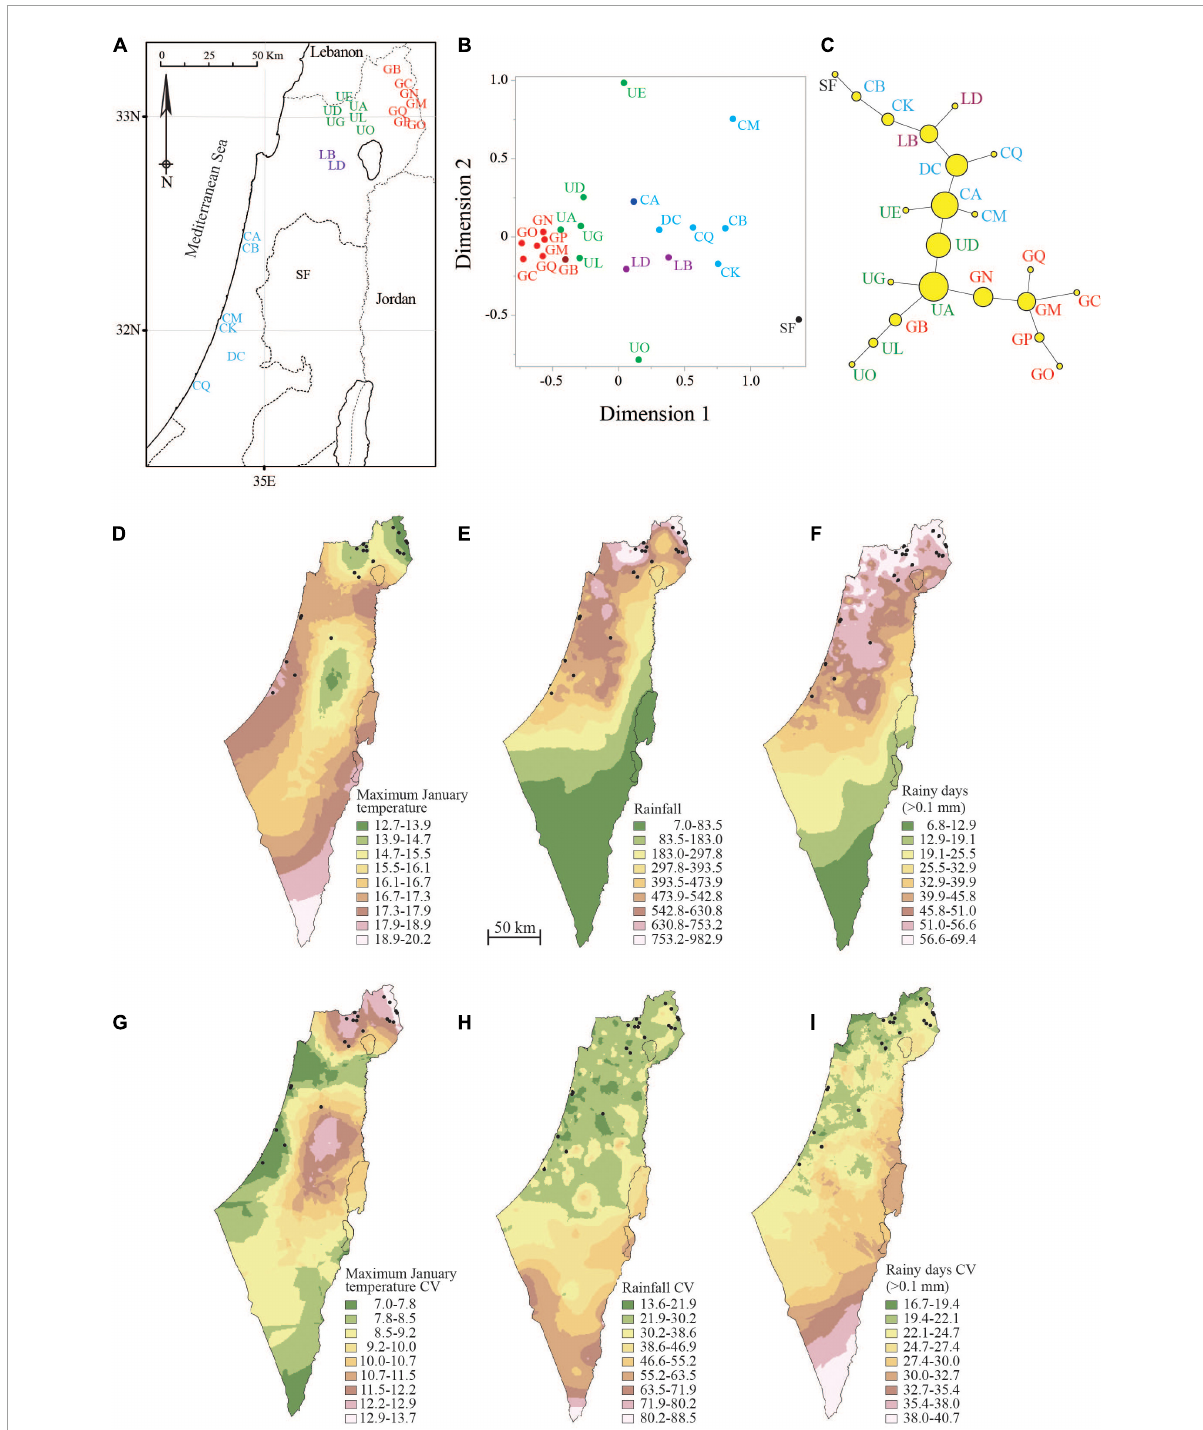
FIGURE1 Location of sampled pools (A) , PROXSCAL multidimensional scaling (B) and minimum spanning network of Nei’s D A distance (C) between pools, spatial projection over Israel of mean annual maximum temperature in January ( D ; ◦ C), mean annual rainfall ( E ; mm), mean annual number of rainy days ( F ; > 0.1 mm), coefficient of variation (CV) of annual maximum temperature in January ( G ; %), CV of mean annual rainfall ( H ; %), and CV of mean annual number of rainy days ( I ; %). Climatic data (133 temperature recording stations and 559 rainfall monitoring stations across Israel) were obtained from the Israel Meteorological Service (IMS) for the years 1999–2018. Vernal pools sampled in this study are denoted by region-colored codes or circles (Golan Heights—red, Upper Galilee—green, Lower Galilee—purple, Samaria—black, and coastal plain—light blue). Node size on the minimum spanning network reflects betweenness